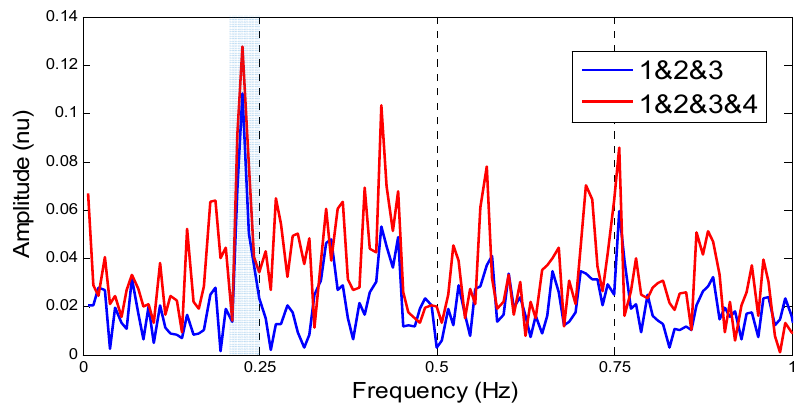
Figure 13. Power spectrum of the detected respiration by fusing channels 1, 3 and 4 (the blue line) and fusing all the channels (the red line). The rectangular shadow denotes the band expansion in the BRIR. The data was measured when the volunteer was (4 m, 0°) away from the radar.